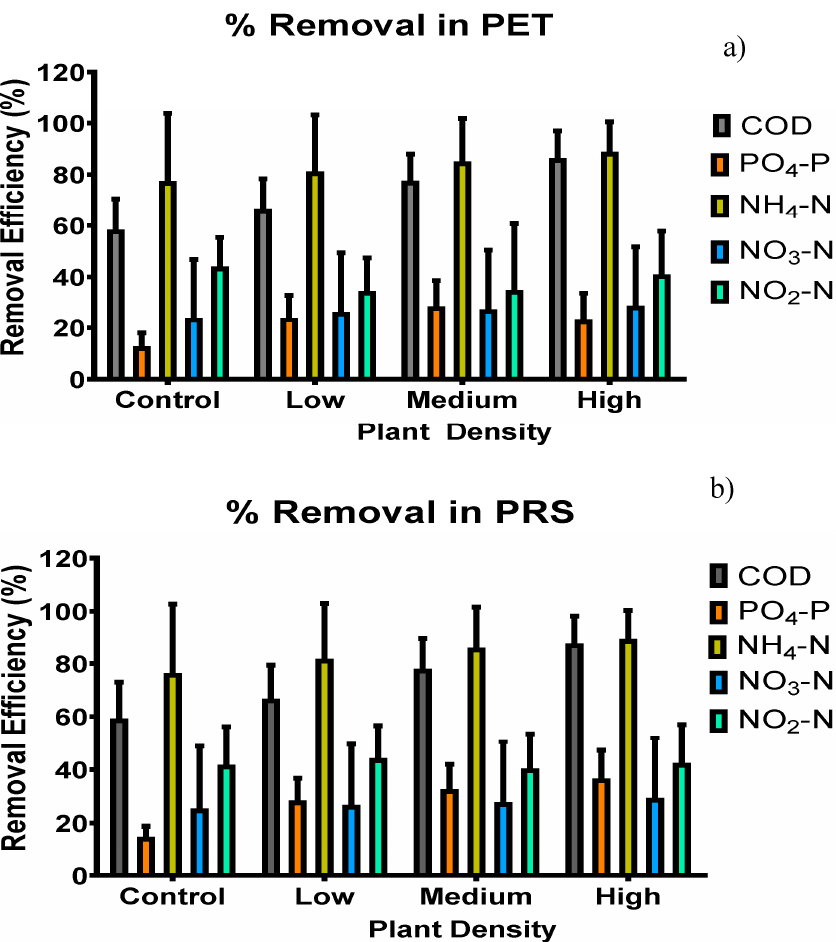
Figure 4. CWs contaminants: ( a ) Removal in PET and ( b ) Removal in PRS. The phosphate concentration (PO 4 -P) in the influent was 10.46 ± 0.25 mg / L. This value